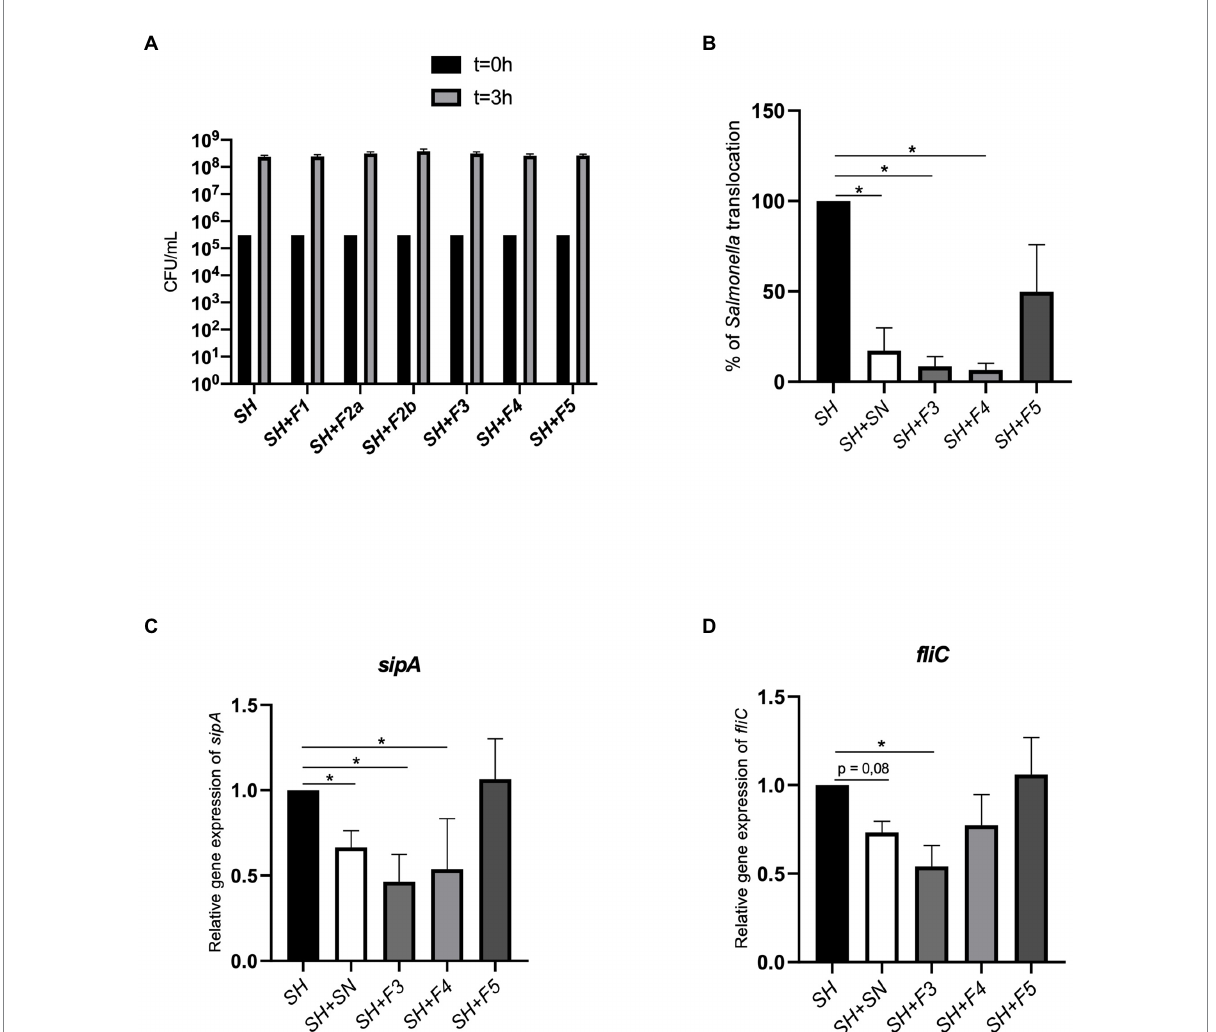
FIGURE 1 F3 and F4 fractions inhibited Salmonella translocation in vitro . (A) Effect of fractions (F1, F2a, F2b, F3, F4, and F5) on Salmonella Heildelberg (SH) growth [colony forming unit (CFU)/ml] after 3 h of infection. (B) Impact of Bacteroides fragilis F3, F4, or F5 fractions and supernatant (SN) on Salmonella Heidelberg translocation across an in vitro multicellular model mimicking the intestinal epithelium. Results were expressed as % of translocation normalized to Salmonella alone (SH). (C) Impact of SN, F3, F4, and F5 on SipA expression, (D) Impact of SN, F3, F4, and F5 on fliC expression. Results were normalized to the cells treated only with Salmonella . The Shapiro and the Kruskall-Wallis tests were performed on n = 5 for this experiment. The Shapiro test was used to verify normality; the one-way ANOVA test was performed on n = 5. All data are presented as means (SEM); * p < 0.05, ** p <